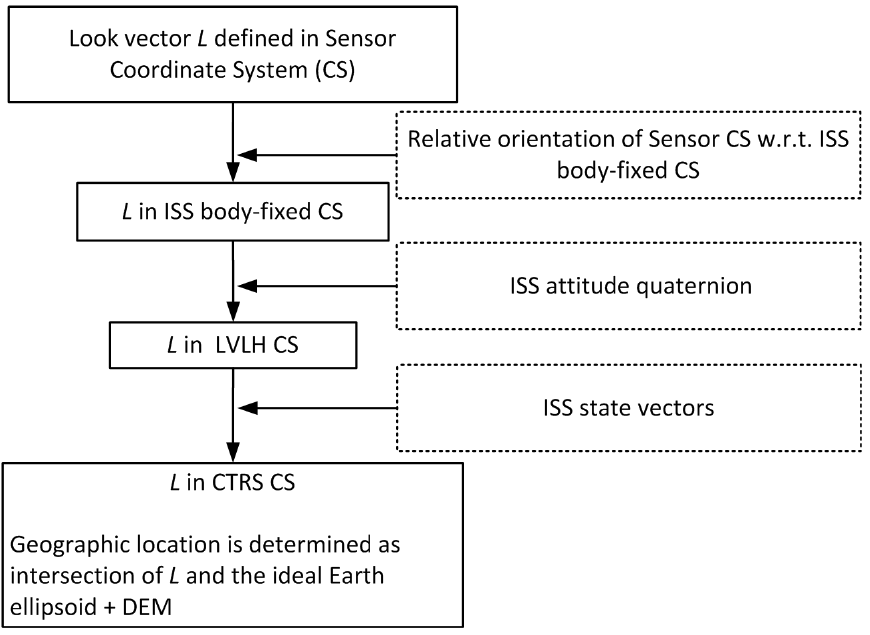
Figure 2. Diagram showing the general concept of the Dou et al. [8] geolocation